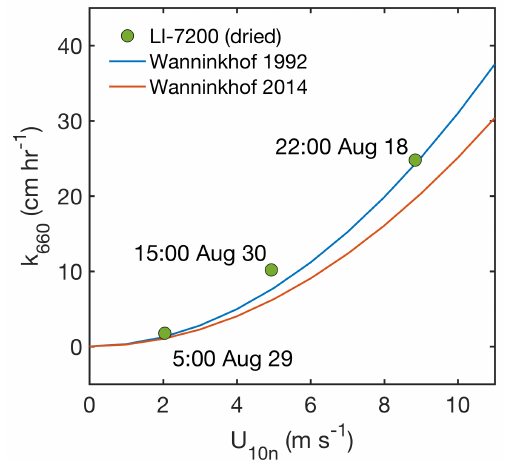
Figure 13. Histograms showing the normalized frequency (%) of p CO 2w calculated using F CO from the EC150, LI-7500, and LI- 2 7200. The limits in the x axis were truncated at − 400 and 1200 for better visualization. However, roughly a quarter of p CO 2w values from both the EC150 and LI-7500 extend beyond these